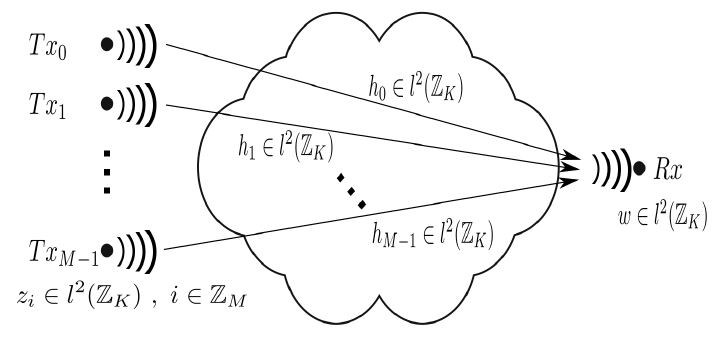
Figure 4. MISO input/output channel